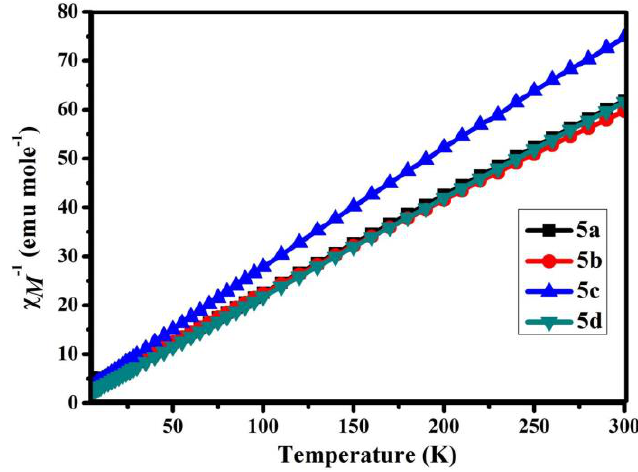
Figure 5. χ M − 1 versus T plot (fit with Curie – Weiss formula, susceptibility data 5 – 300 K) for all B-L MILs.